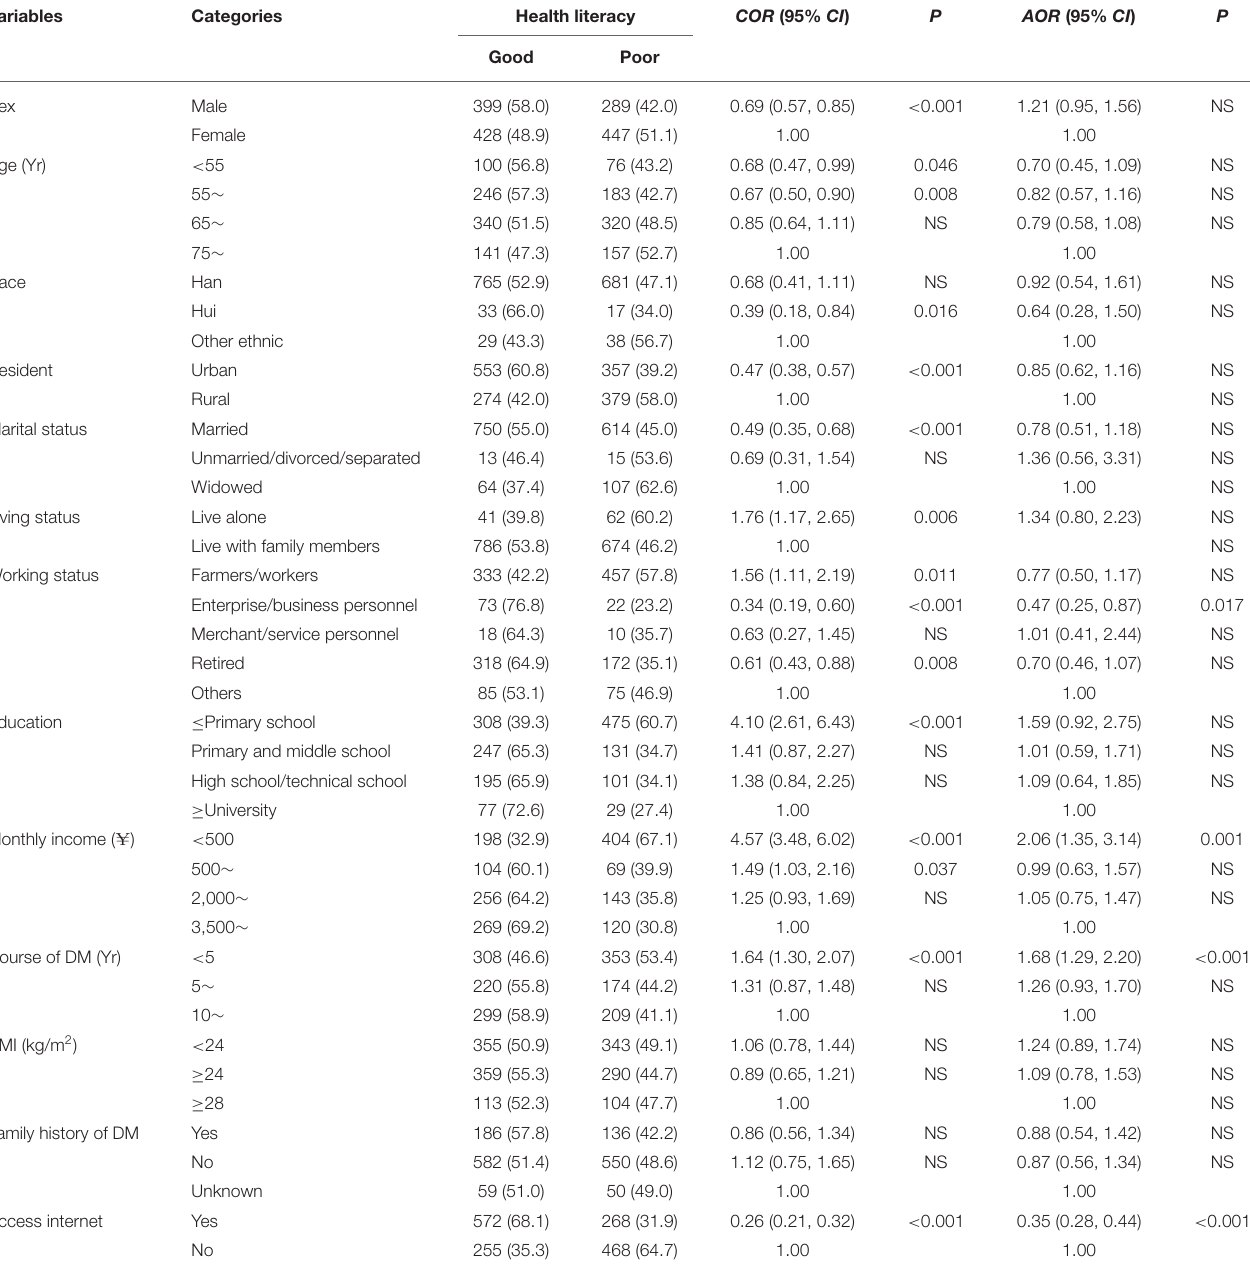
TABLE 1 | Bivariate and multivariate analyses of factors associated with health literacy level among the respondents [ n ,